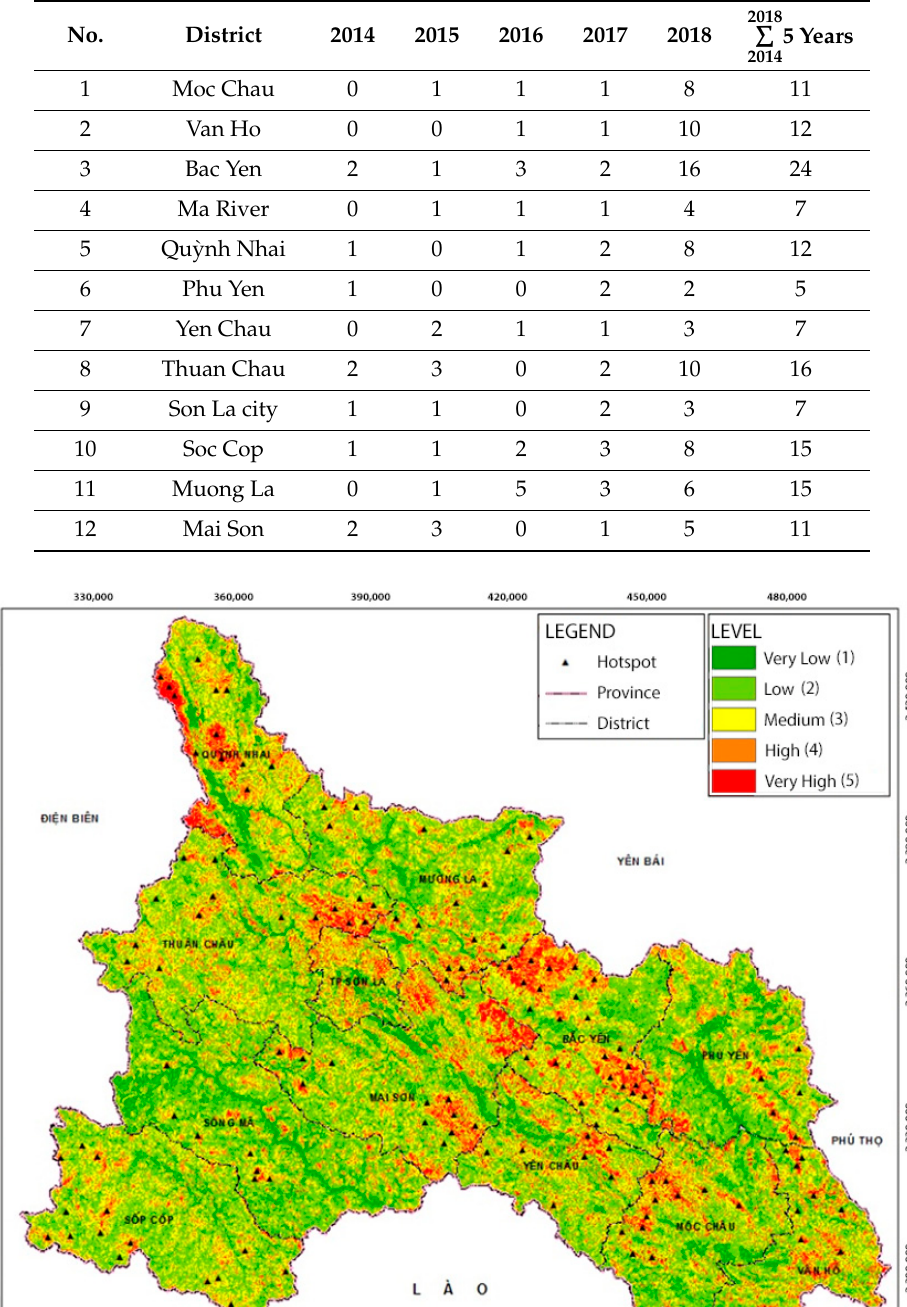
Table 5. Historical forest fires from 2014 to 2018 in Son La Province.